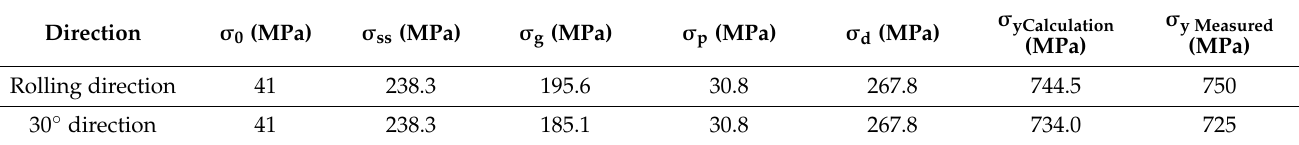
Table 8. Yield strength calculation results and measured